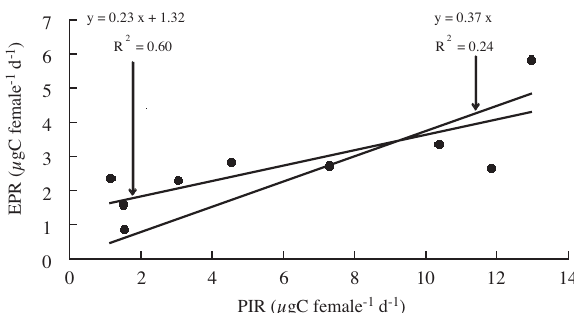
F IG 4. – Linear regressions between carbon specific pigment inges- tion rate and egg production rate of C. sinicus , with and without intercept forced into